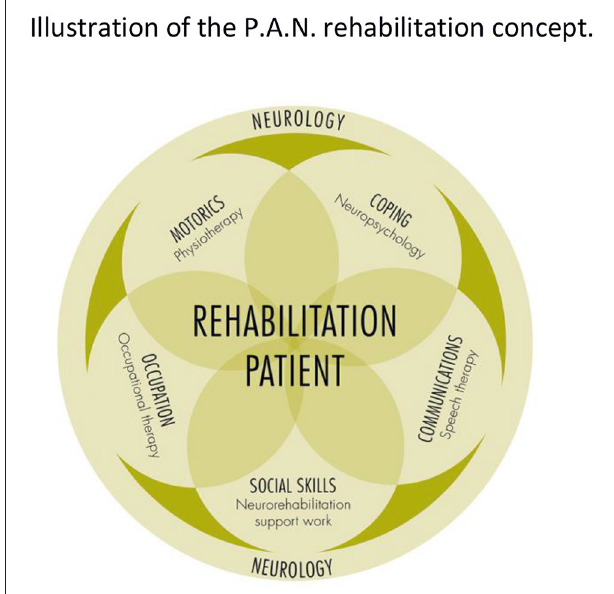
FIGURE 2 | Illustration of the P.A.N. rehabilitation concept. Hallmark of this concept is a holistic approach with interdisciplinary support of rehabilitation, where all therapeutic intentions are tied into 24/7 program of learning to live independently. Patients live in groups of 14 in a home-like setting. Within these groups level of support is titrated to individual needs and hence allows for “round the clock” practice and the continous adjustment of goals. Going through neurorehabilitation while living in groups further supports communication and practice of social skills.